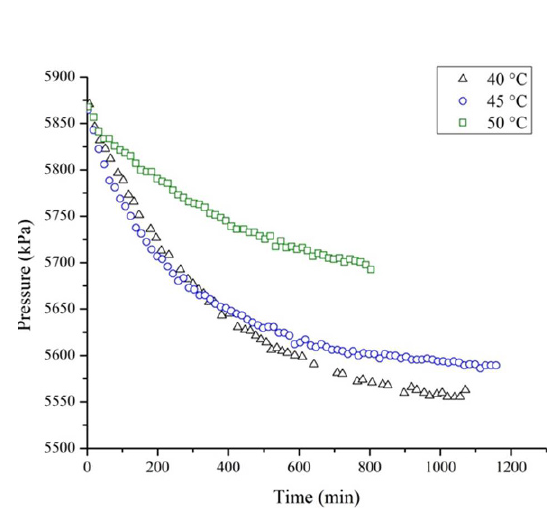
Figure 3. Pressure decay graphs at different temperature with equal initial pressure (5900 kPa).